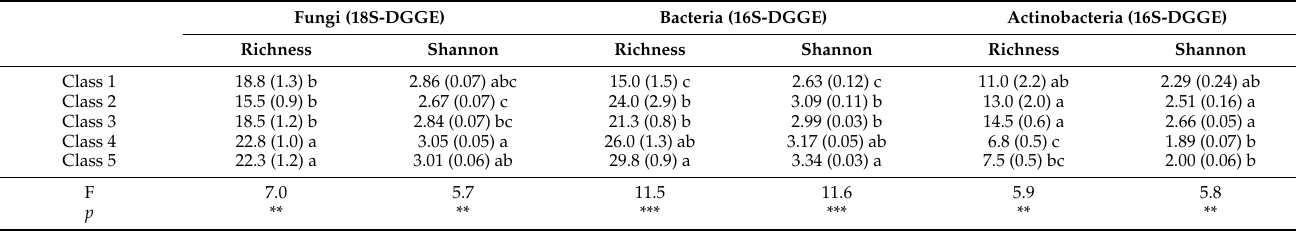
Table 2. Average Richness and Shannon index calculated on 18S rDNA-DGGE band profiles from fungal community and on 16S rDNA-DGGE band profiles from bacterial and actinobacterial communities in decaying black pine deadwood, on the basis of decay class. Standard error in parentheses. Different letters in a column indicate significant differences at p < 0.05 (LSD test) among